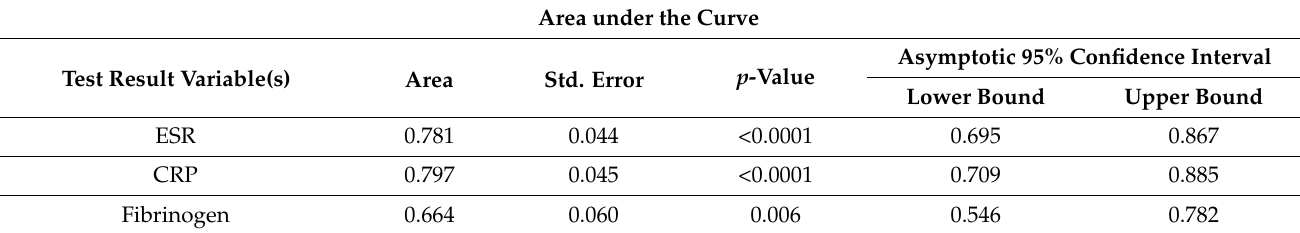
Table 9. AUC analysis: the biomarkers’ capacity in predicting mortality.